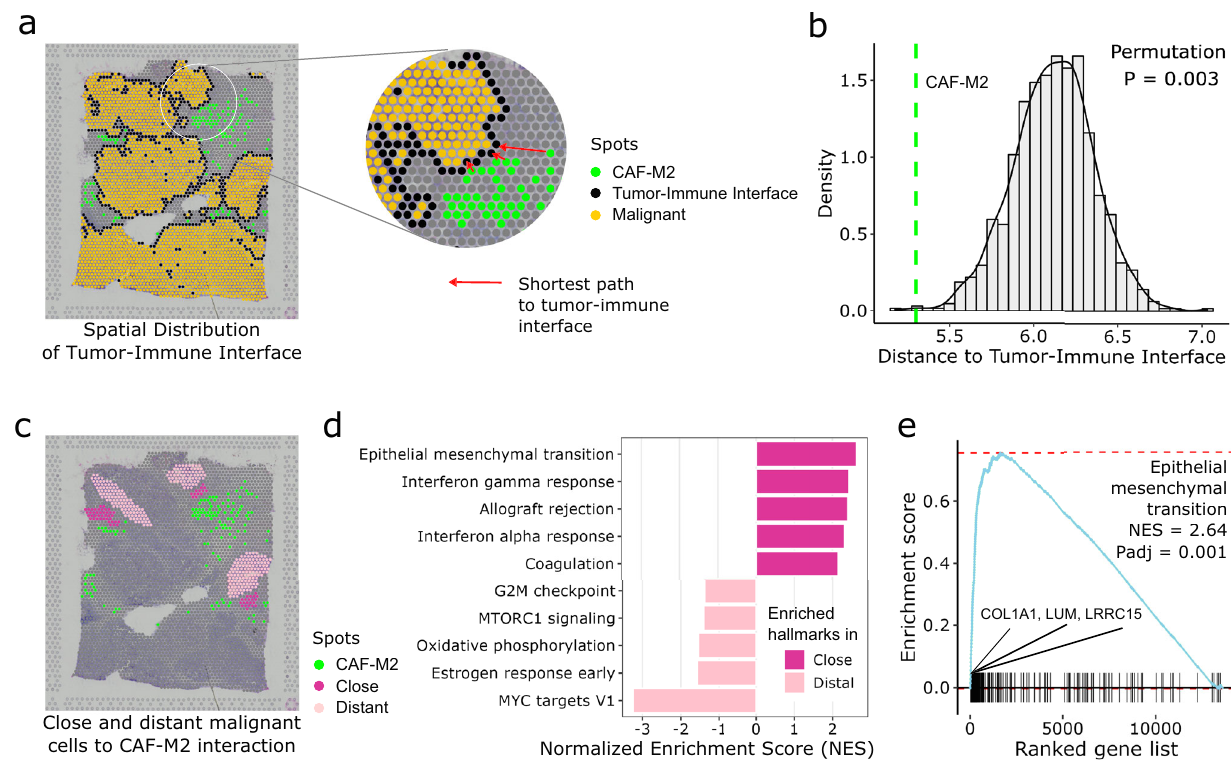
Fig. 6 | Associationbetween CAF – M2interactions and malignant cell invasion. a T he CAF – M2 spots at the interface between the tumor and immune regions in a breast tumorexample.The distancebetweenaCAF – M2spotandatumor-immune interface is the shortest path of this spot to the interface. b Distance between CAF – M2 interaction spots and tumor-immune boundaries. The green line repre- sents the average distance between each CAF – M2 spot and the tumor-immune interface. The null distribution of distance was computed through 1000 rando- mizations. c The spots of close and distant malignant cells relative to CAF – M2 interaction spots. d Gene set enrichment analysis (GSEA) of the differential expressionbetweencloseanddistantmalignantcellstoCAF – M2spotsconditioned